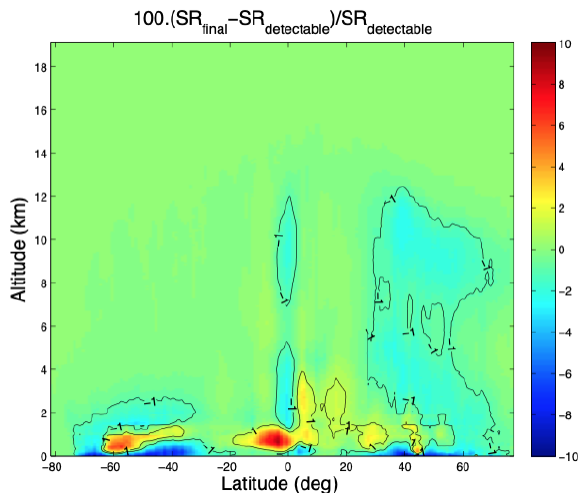
Figure 11. Relative difference (in %) between the SR_observable field and the SR_detectable field both computed by E3SMv1, as a function of latitude and